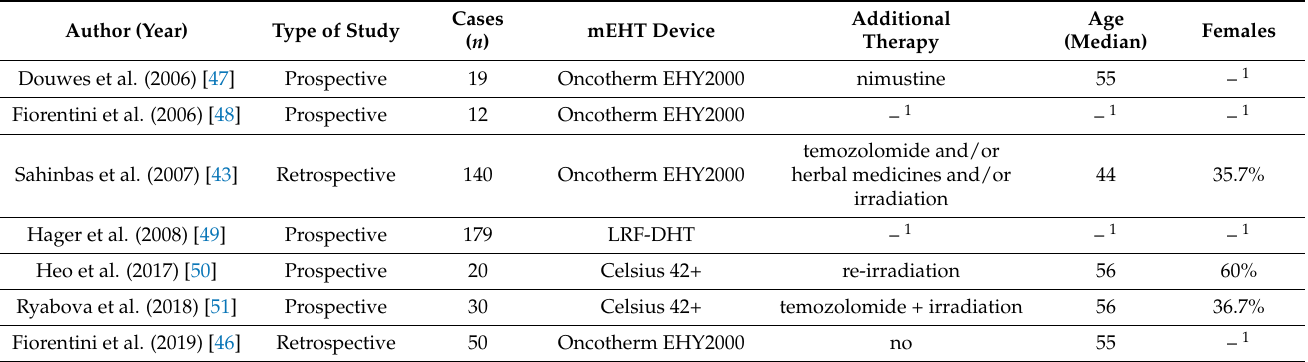
Table 1. Details of the selected studies investigating the effect of modulated electro-hyperthermia (mEHT) in